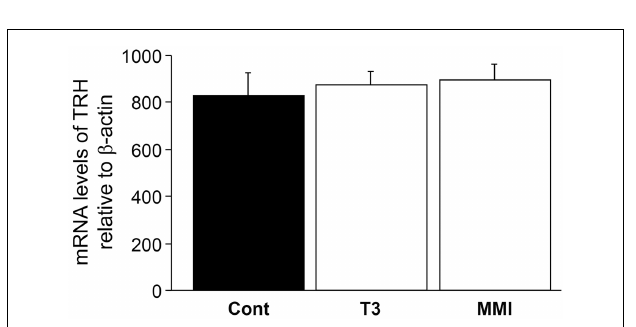
FIGURE 6 | Effect of thyroid hormone manipulation on thyrotropin- releasing hormone (TRH) mRNA levels .There was no significant effect of thyroid hormone (T3) and MMI onTRH mRNA levels in the male